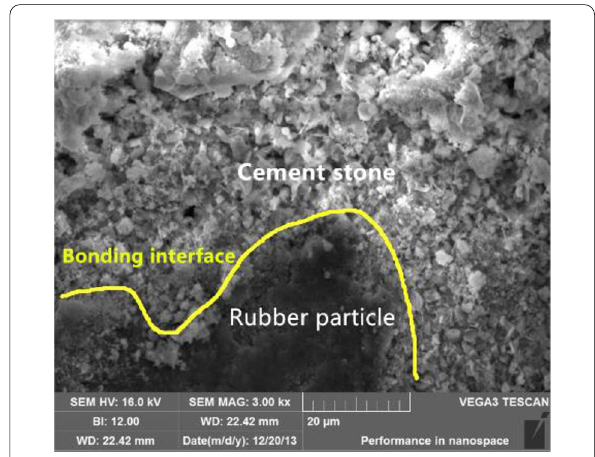
Fig. 10 Electron microscope image of adhesive interface between treated RP and cement stone